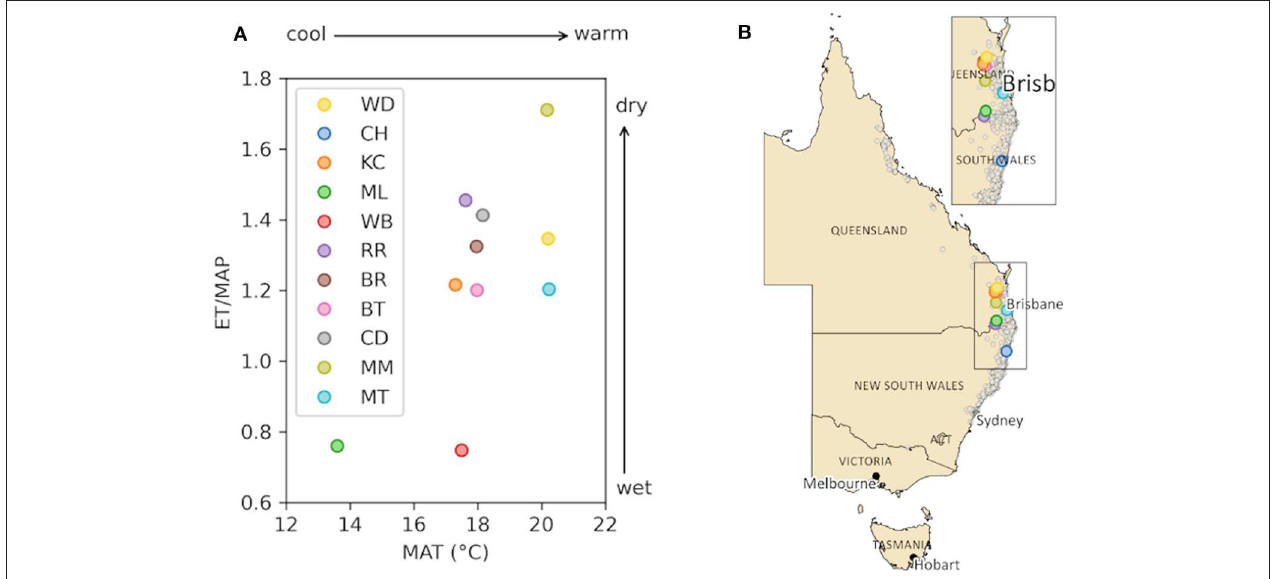
FIGURE 1 | Climate parameters and location for the 11 selected E. grandis sites (each provenance with a unique color). (A) Relationship between evapotranspiration/mean annual precipitation (ET/MAP) and mean annual air temperature (MAT). (B) Records of E. grandis from Atlass of Living Australia (2020) (light gray dots) and provenances location on a map of Eastern Australia (area of interested enlarged in inlet). Note that higher ET/MAP signifies greater water